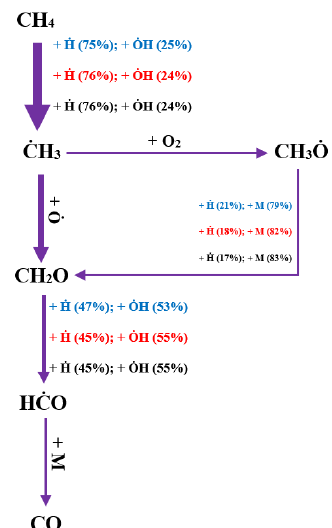
Figure 5. Flux analysis of methane consumption (20%) at three different temperatures corresponding to the axial distance where CH 3 mass fraction starts to rise: (Blue) 1330 K (D wire : 0.1 mm); (Red) 1420 K (D wire : 0.15 mm); (Black) 1430 K (D wire : 0.25 mm); “M” refers to a third body reaction.